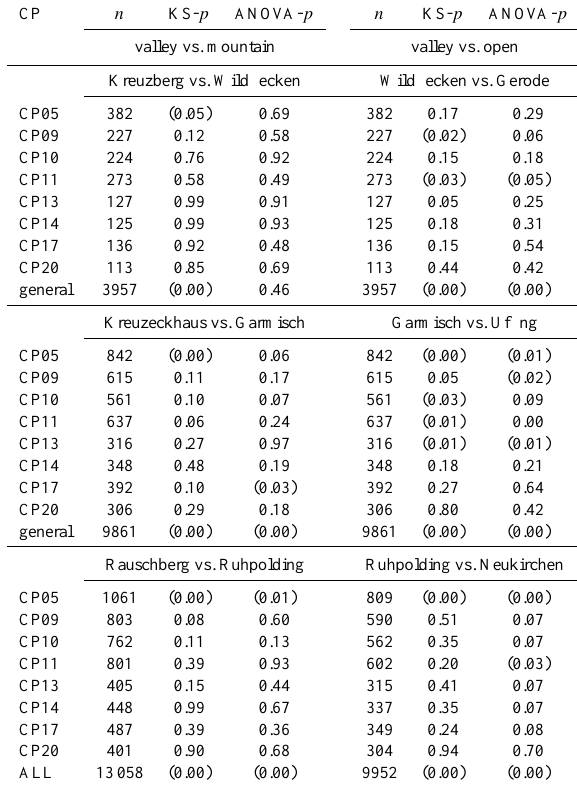
Table 5. Statistical test results of station group in